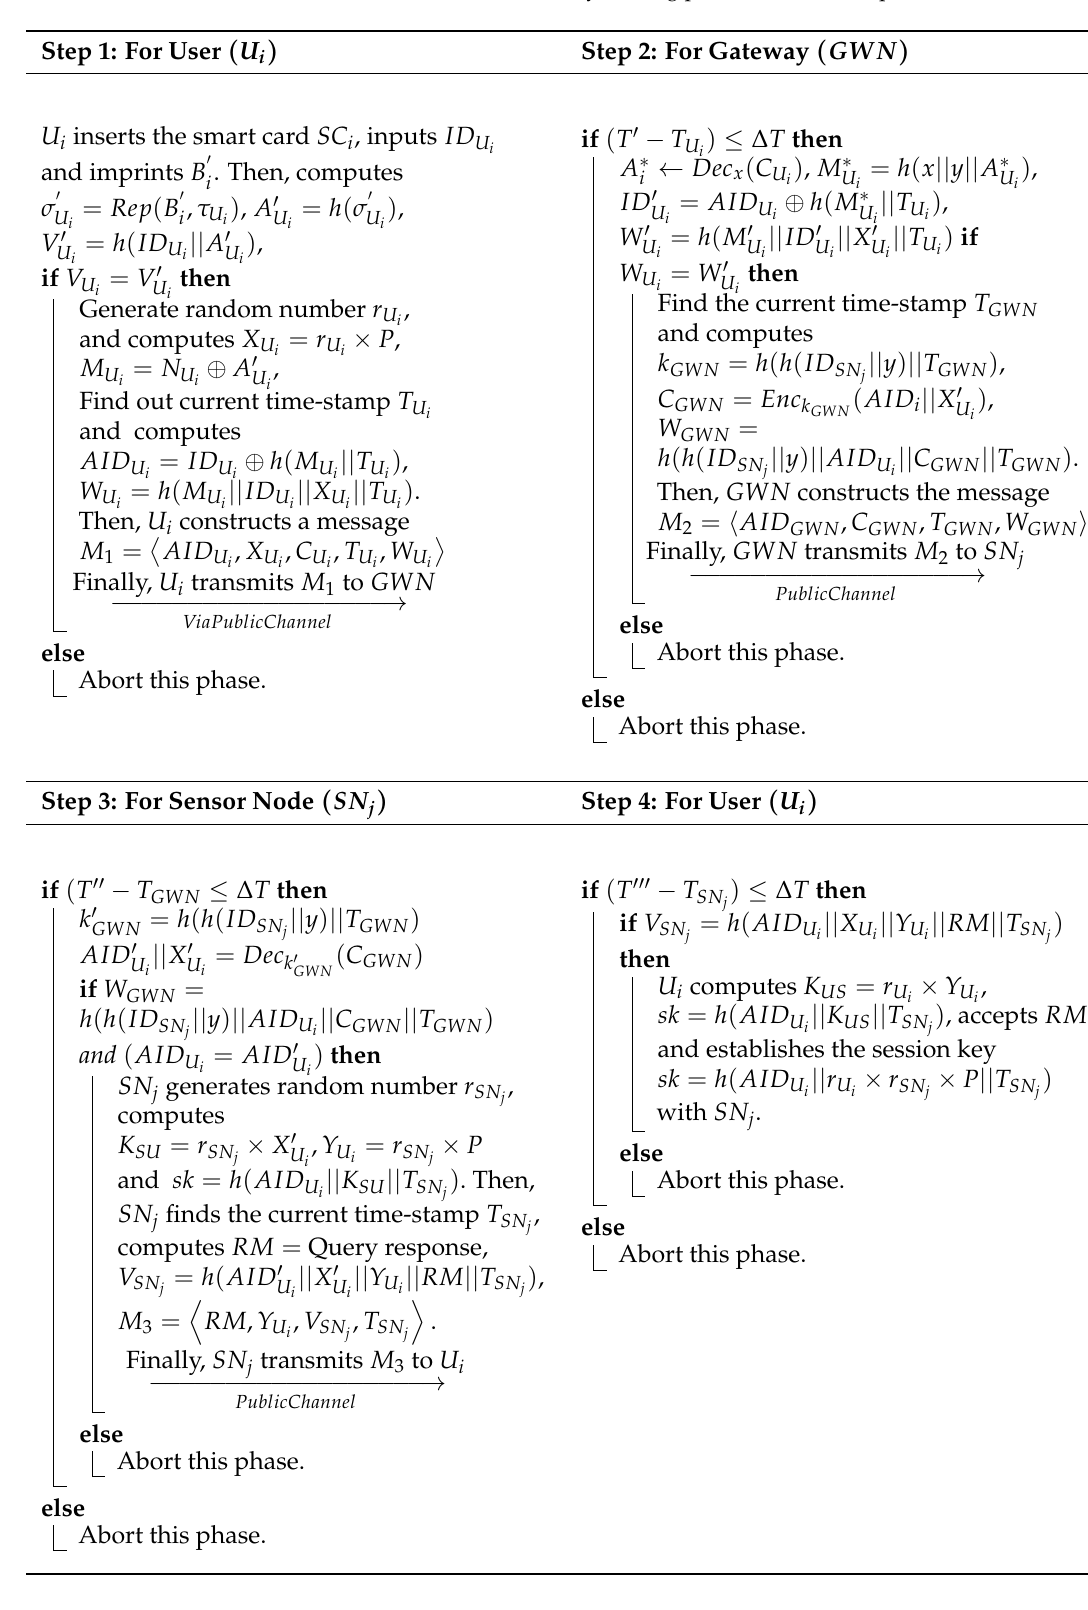
Table 6. U i ’s authentication and session key sharing phase of Park et al.